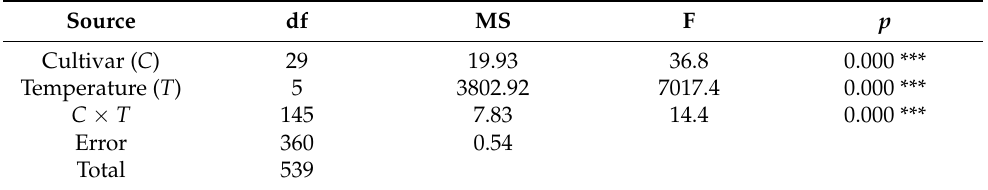
Table 5. Two-way analysis of variance for MGT of 30 biomass sorghums at a range of